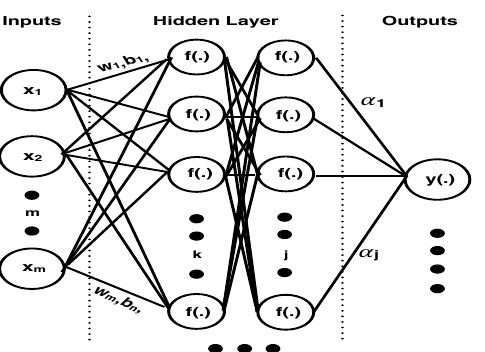
Figure 1. General architecture of the neural network employed by AKPE. The first layer is the input layers, with m nodes signifying m experimental data points. The second layer is where each nodes were transformed by activation function ( f ( . ) ) and other reaction model related transformations (first/second order derivatives or reacting species calculations.). The third layer is the outputs from the neural